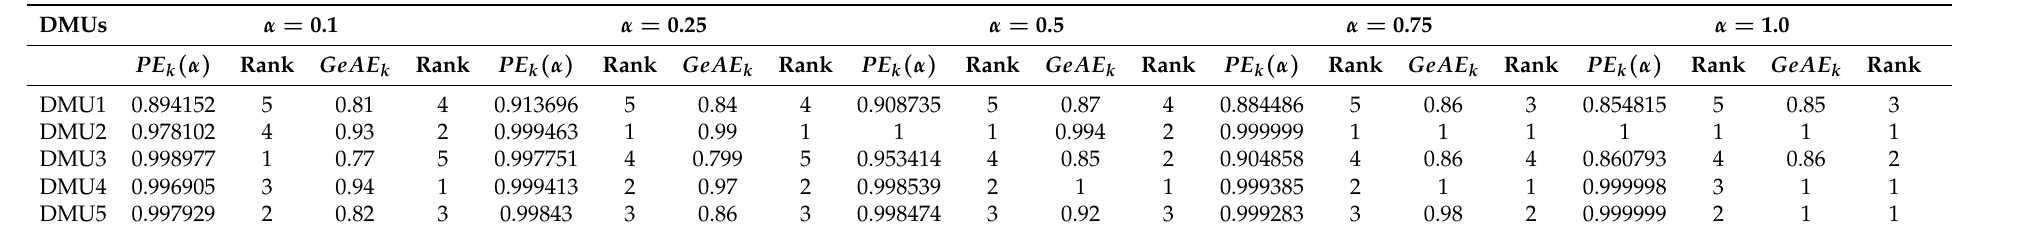
Table 3. Comparison of the proposed efficiency (PE) and geometric average efficiency(GeAE) and